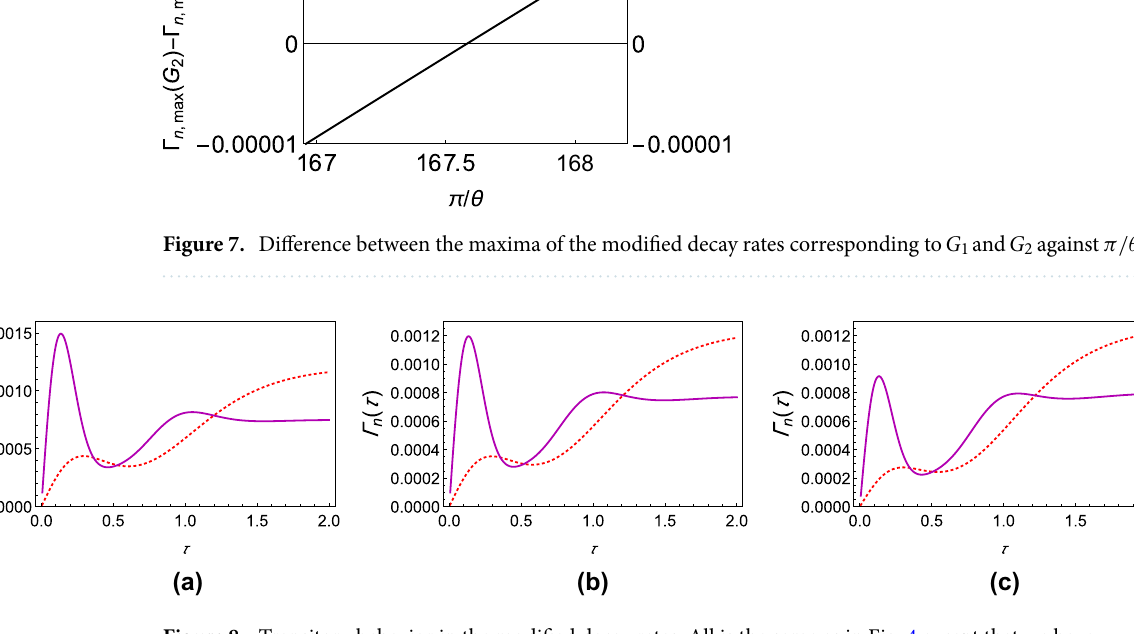
π/ 150 , θ c π/ 167 , and θ π/ 190 , = = =